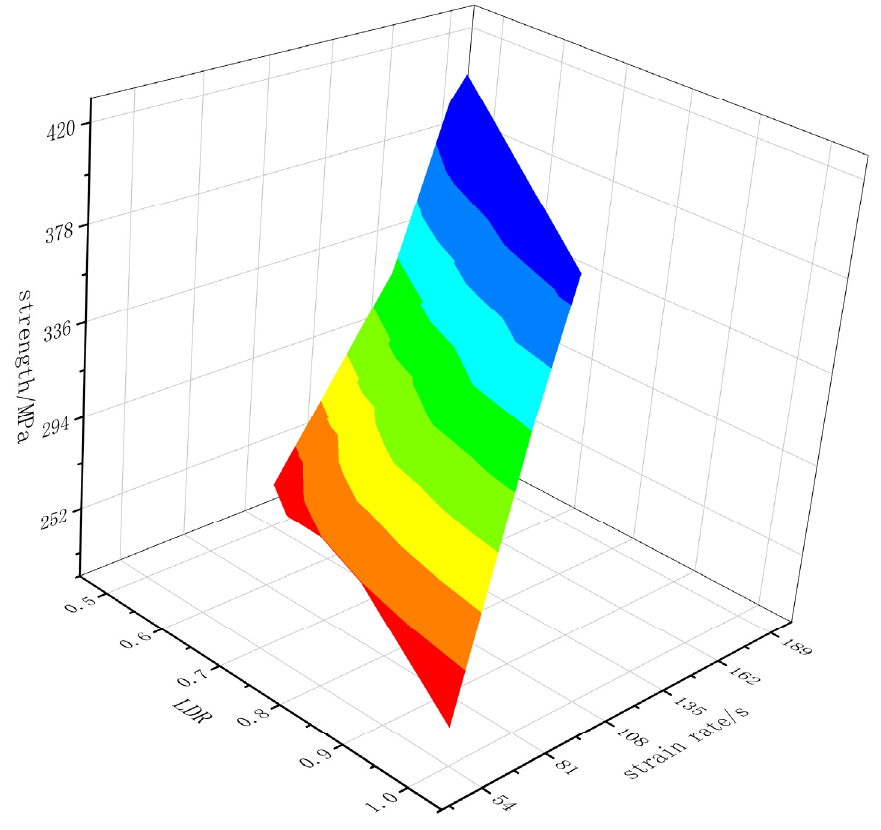
Figure 8. Rock strength law with size effect and strain-rate effect